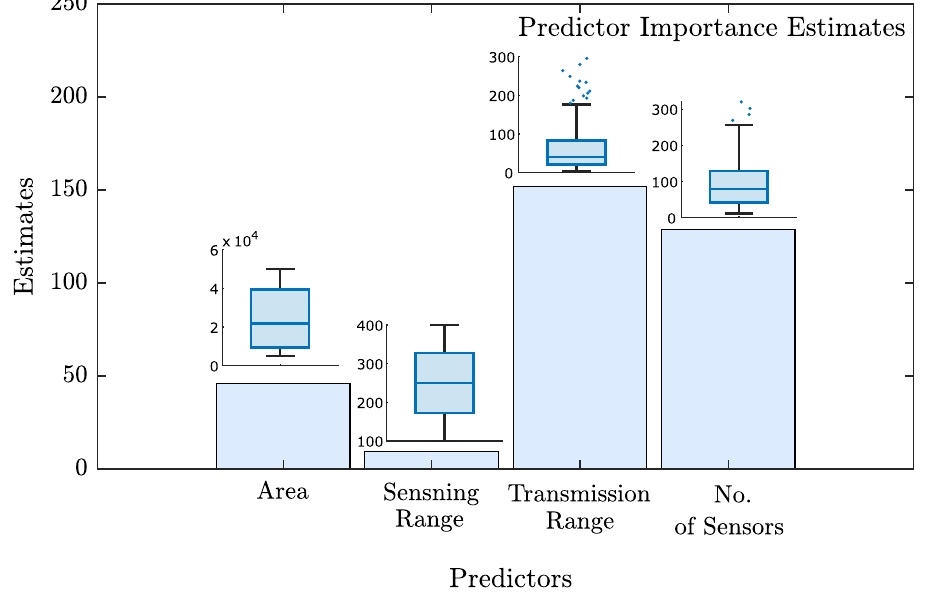
Figure 2. Graph showing the relative predictor importance score for all four predictors. The estimates for the area of the RoI, sensing range of the sensor, transmission range of the sensor, and the number of sensors are 46.0, 9.3, 152.0, and 128.9,